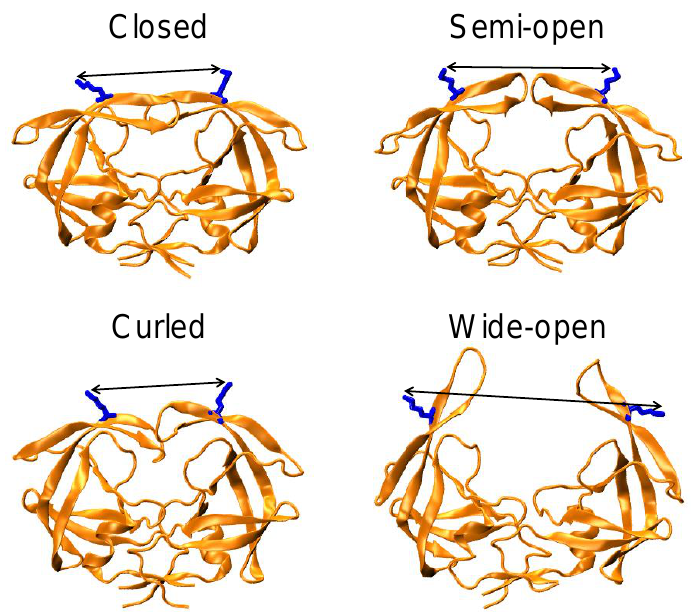
Figure 1. Four representative conformations of populations to describe HIV-1 PR conformational landscape, namely closed ~ 33 Å (PDBID: 2BPX), semi-open ~ 36 Å (PDBID: 1HHP), curled ~ 25-30 Å (MD coordinates) and wide-open > 40 Å (MD coordinates). Residues K55 and K55′ are rendered in blue stick format with the side chain distance between them shown as arrows.